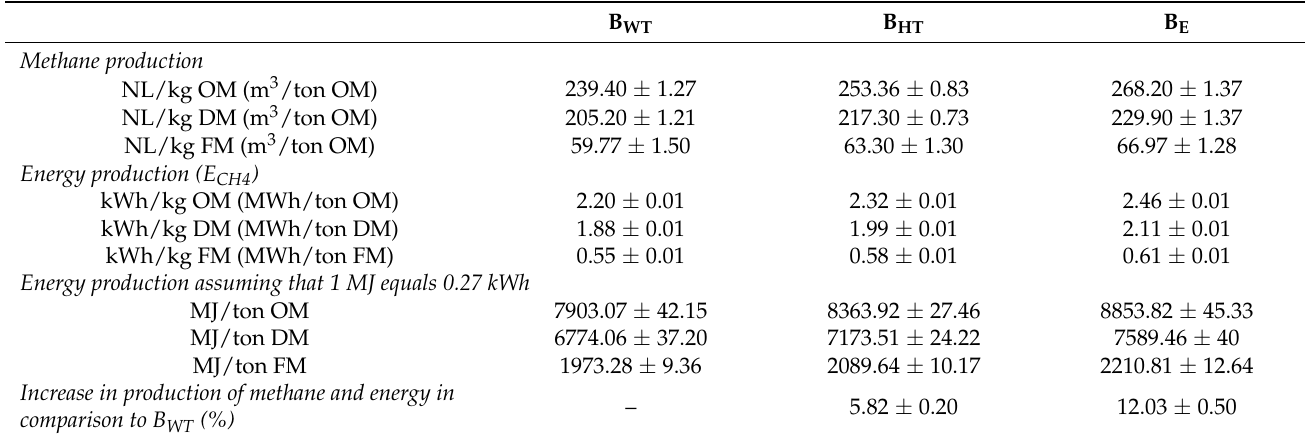
Table 3. The energy effectiveness of MP from biowaste without and after pre-treatment. B WT B